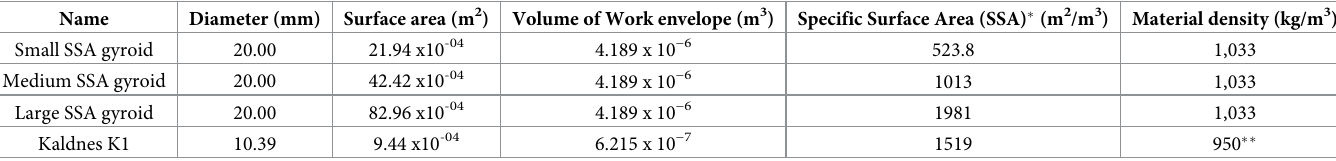
Table 1. Biocarrier designs and their geometric and material characteristics.